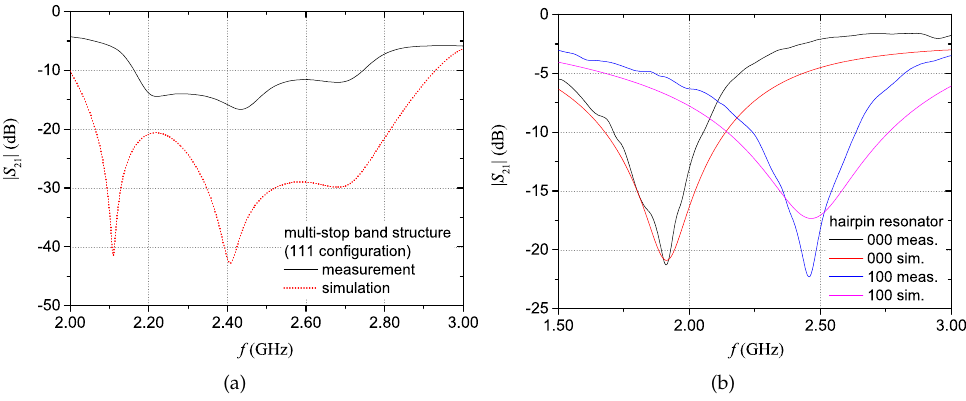
Figure 12. Direct comparison between simulation and measurement results for the multi-stopband tag ( a ) and for the hairpin resonator tag ( b